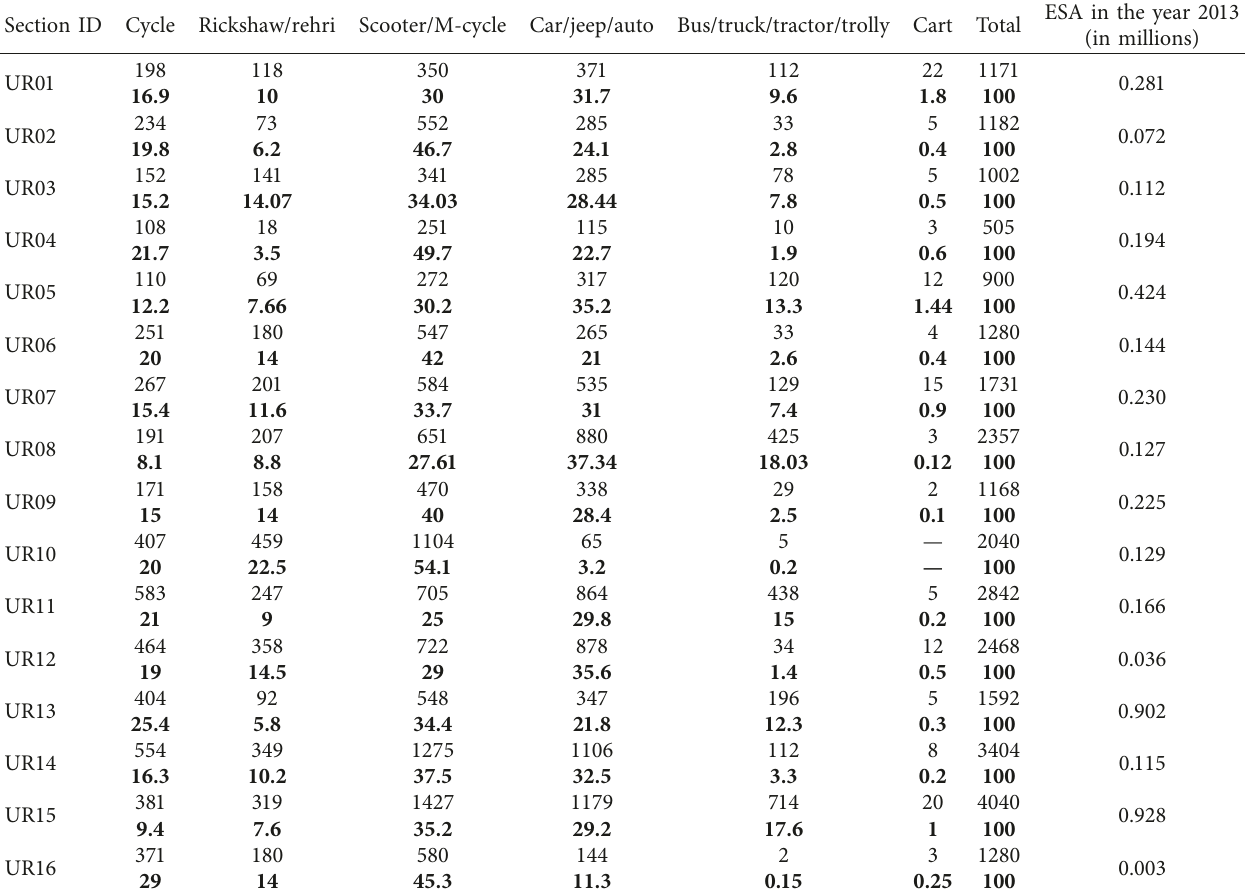
Table 2: Traffic volume data of road sections.